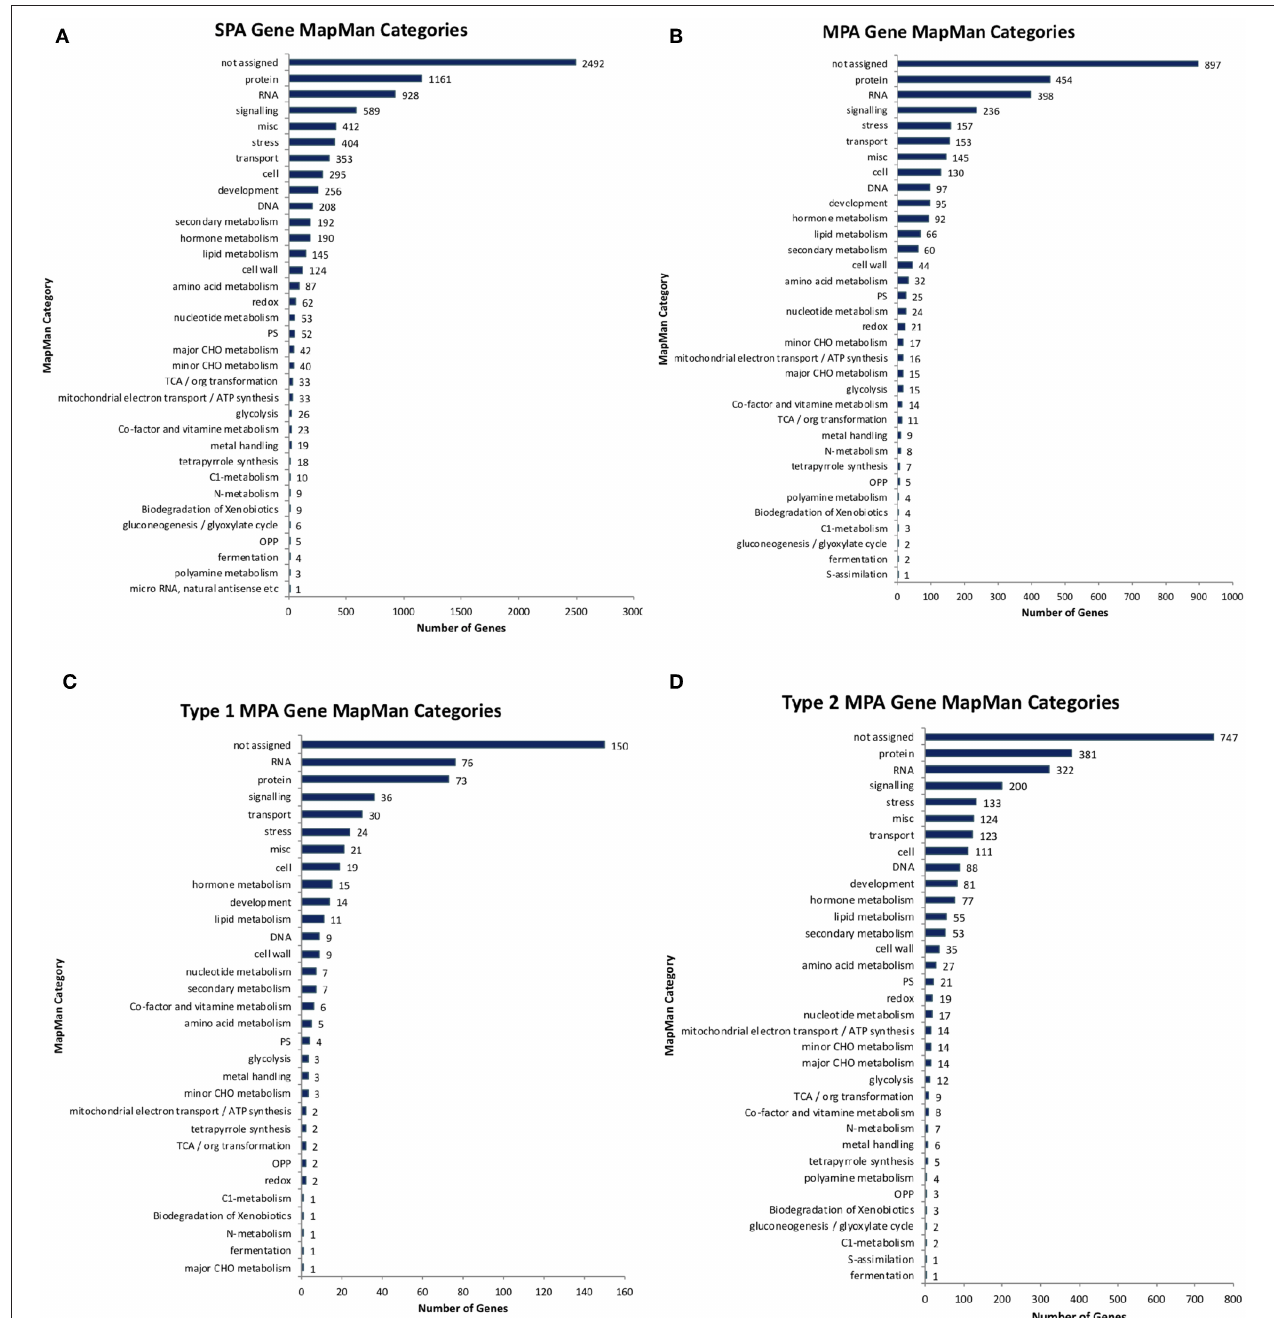
FIGURE 11 | Functional annotations. Number of genes annotated with different high-level MapMan categories for (A) non-MPA genes, (B) all MPA genes, (C) type 1 MPA genes, and (D) type 2 MPA genes.